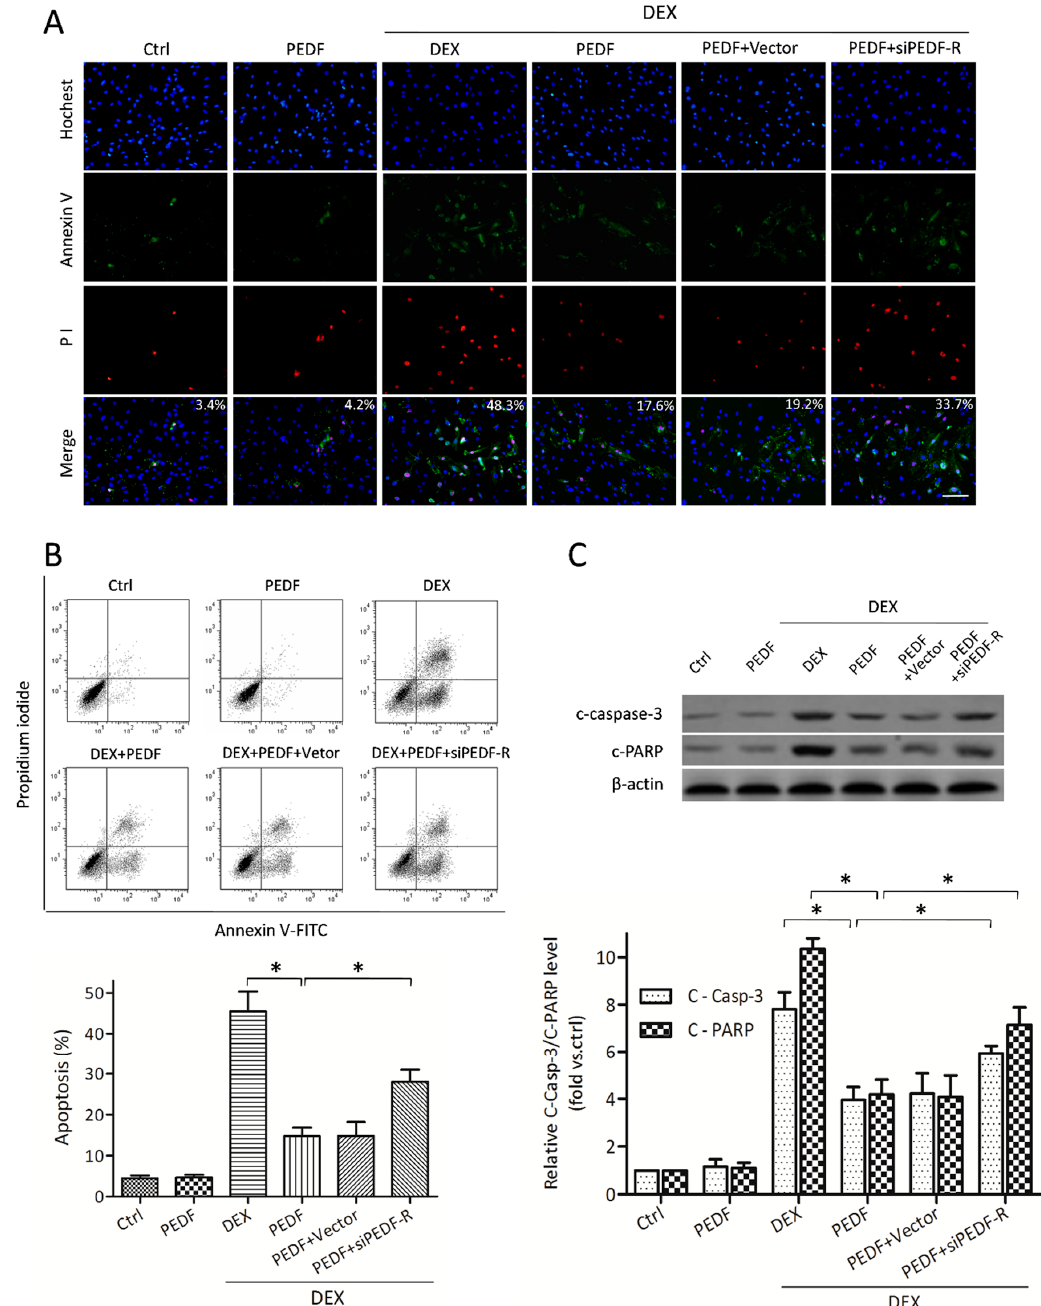
Figure 4. The effect of PEDF on DEX-induced MC3T3-E1 pre-osteoblast apoptosis. MC3T3-E1 cells treated with or without rPEDF (10 nmol/L) were exposed to 10 − 5 mol/L DEX for 24 h. ( A ) Annexin V/PI and Hochest33342 staining assessed by fluorescence microscopy was performed to evaluate apoptosis (Annexin V+/Hochest+, mean percentage from 20 observation fields, bar = 200 μ m); ( B ) FACS was also employed to quantify Annexin V/PI staining for apoptosis assessment. Results are expressed as apoptosis percentages (Annexin V+/Hochest+, n = 4, * p < 0.05); ( C ) Western blot showing the levels of cleaved caspase-3 and PARP ( n = 5, * p < 0.05). Results were presented as fold induction, relative to control. Data are mean ± SD.